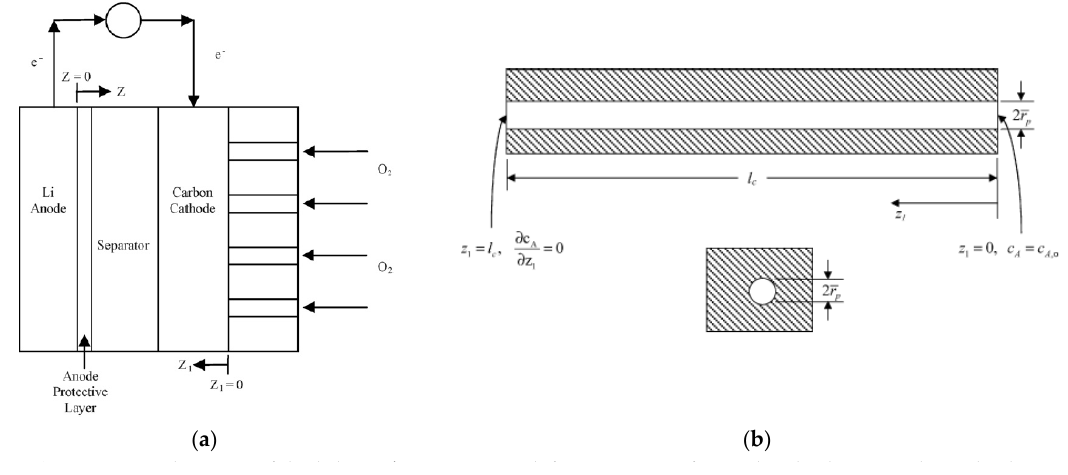
Figure 2. ( a ) Schematic of the lithium/air system and ( b ) geometry of an individual pore in the cathode reaction layer. Reprinted from Sandhu et al. [15], with permission from Elsevier.